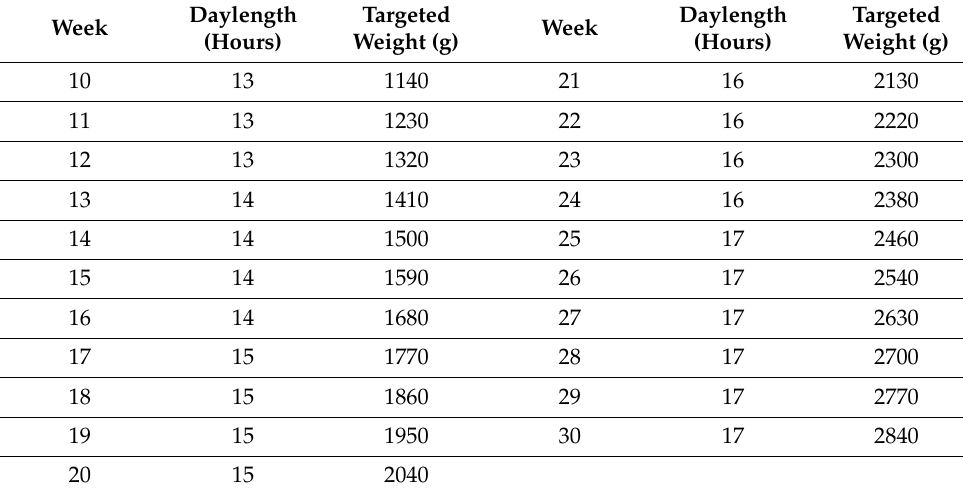
Table 2. Lighting schedule during experiment period and targeted weight of the